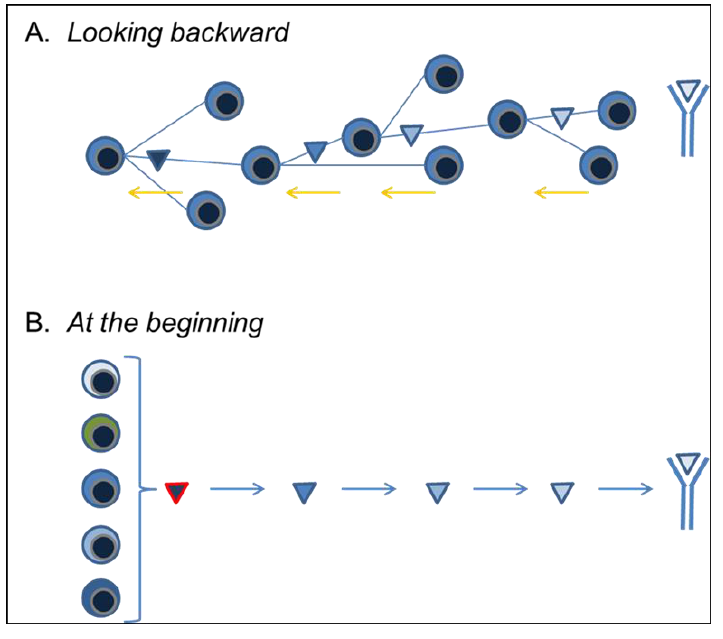
Figure 1. Synopsis of proposed vaccine strategies. ( A ) The B-lineage vaccine approach to eliciting HIV-1 bnAb responses in vaccinees is based on the recapitulation of clonal evolutionary pathways that lead to bnAb in a single HIV infected patient [2,54]. This approach relies on the technical capacity to identify, recover, and characterize bnAb B cells and/or plasmacytes from HIV-1 infected patients. BCR encoding gene rearrangements isolated from single bnAb cells are then used to to follow the bnAb response backwards, in effect, reversing B-cell evolution to identify antigen-ligands that might re-create this (or comparable) bnAb pathways in many individuals [2]. In this way, vaccine ligands can be generated and optimized to select for the desired—bnAb—evolutionary pathway; ( B ) The ancillary approach is us to identify those cells in the naïve B-cell pools capable of recognizing HIV-1 neutralizing epitopes and/or optimized, lineage design, vaccine immunogens. In this approach, cultured B cells are driven to proliferate by exposure to CD154 and immunogens capable of driving bnAb production can be modified to activate the largest possible pool of specific B cells. In consequence, we can study HIV-1 antigen epitopes without regard to their ability to elicit significant humoral responses: antigenicity minus